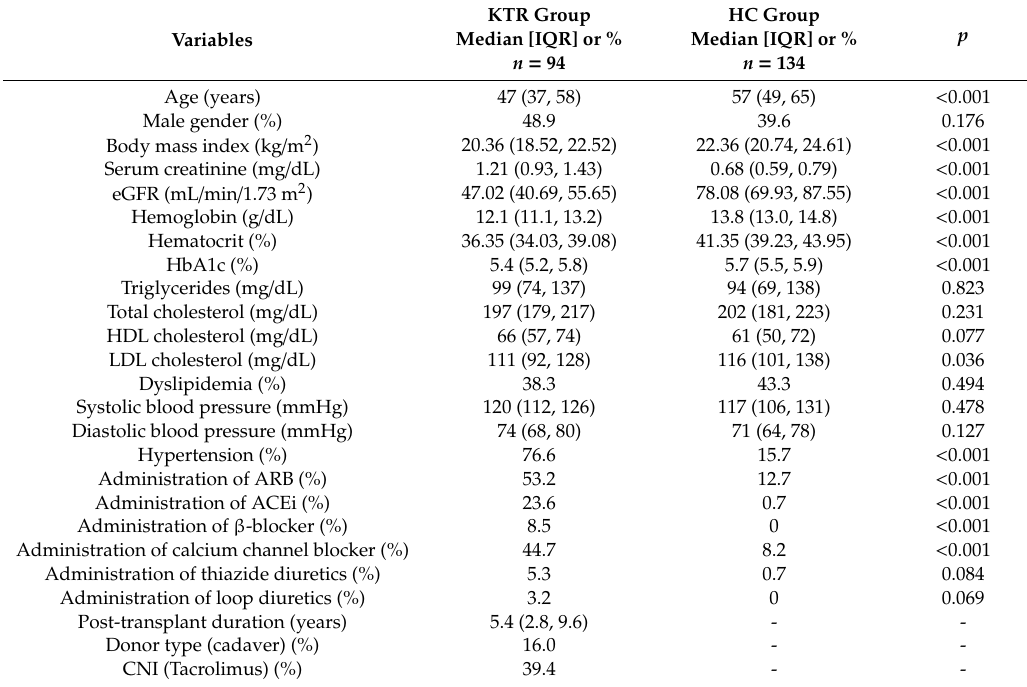
Table 1. Clinical characteristics of kidney transplant recipients and healthy